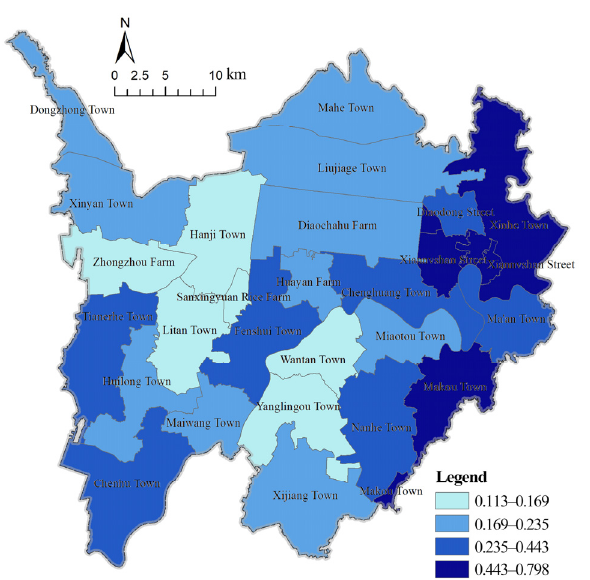
Figure 5. Spatial distribution of the comprehensive evaluation results of urban–rural integration development.